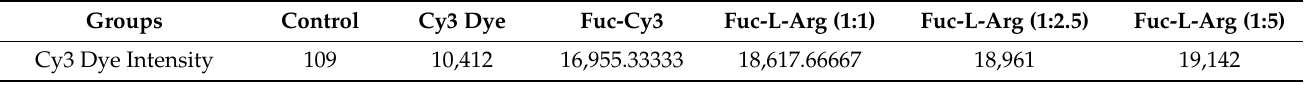
Table 3. Fluorescence intensity of different complexes in HeLa